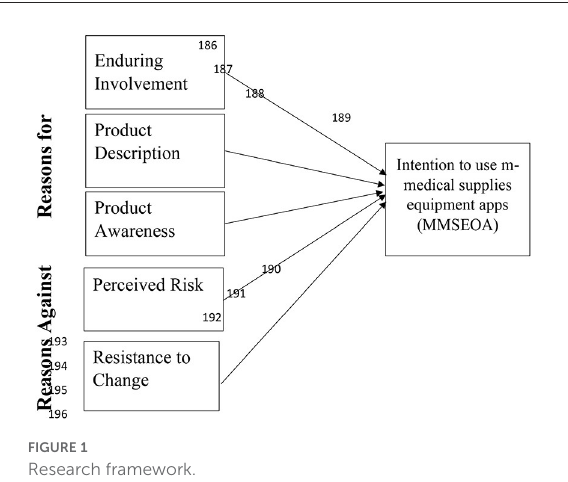
FIGURE1 Research